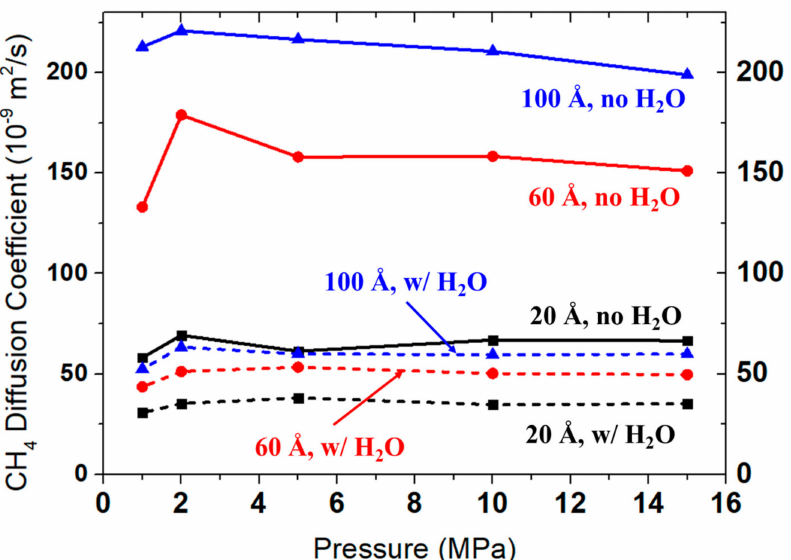
Figure 5. Di ff usion coe ffi cients of CH 4 in the coalbed models with varying pore sizes. Solid and dashed lines show the cases where CH 4 alone or a mixture of CH 4 and H 2 O is adsorbed in the cell, respectively. Blue, red, and black lines represent the results generated from models with 100 Å, 60 Å, and 20 Å pore sizes,